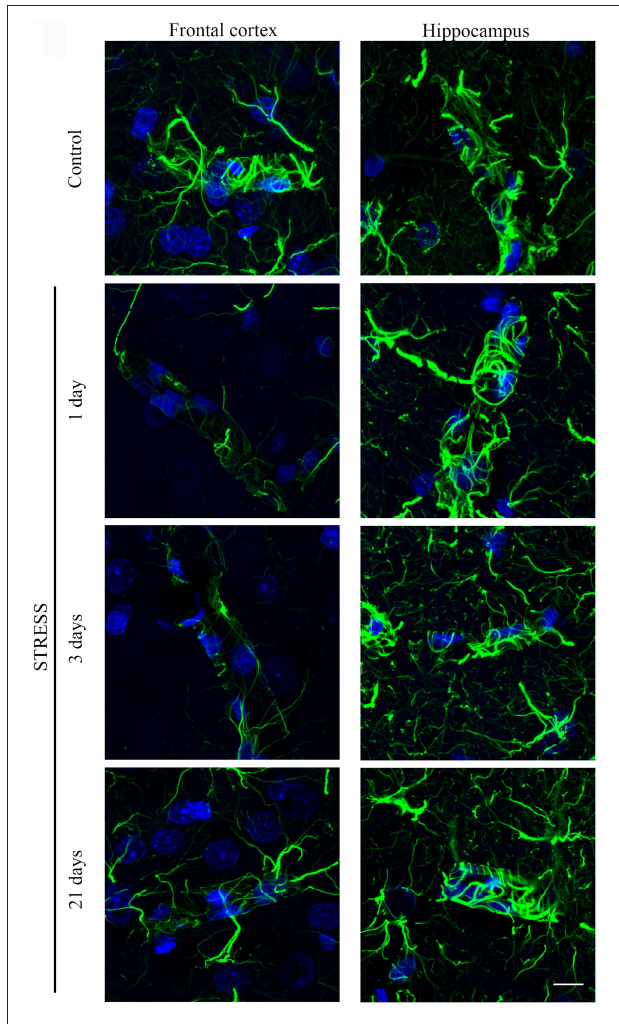
comparison tests. *** p < 0.001 , significant differences as compared to the unstressed control